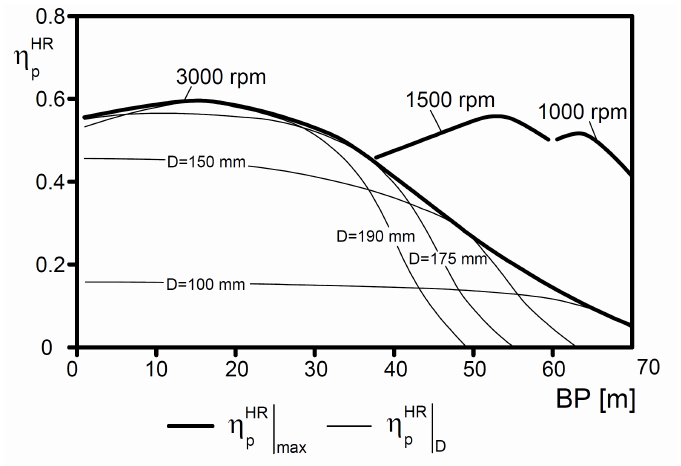
Figure 7. Efficiency variability of different machines with